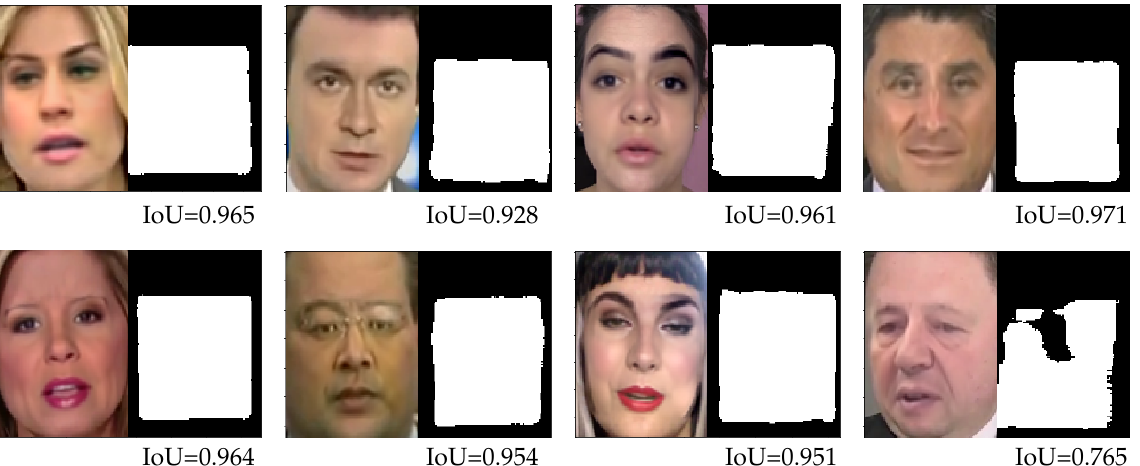
Figure 2. Randomly selected images from the result of detecting the fake images by the model trained with the Deepfakes dataset. The left side of every pair of sub-images is the fake image and the right side of every pair of sub-images is the prediction